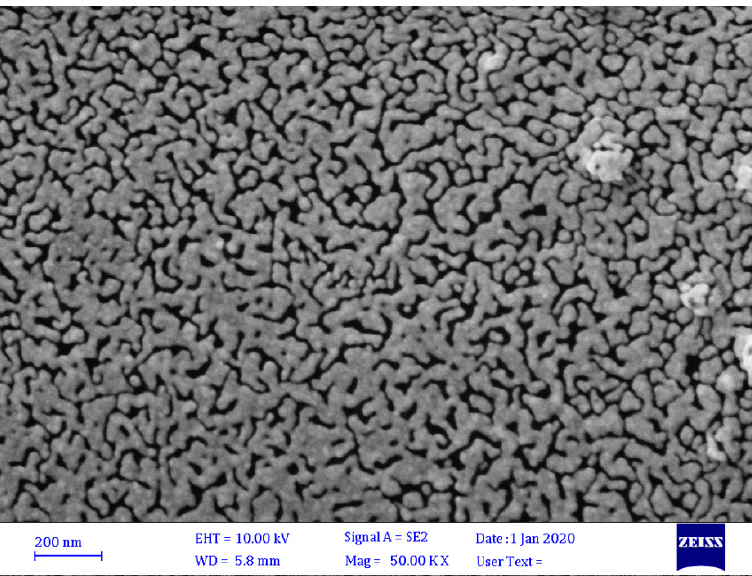
Figure 7. Field-emission scanning electron microscopy (FESEM), blank PVC images before exposure to UV light.